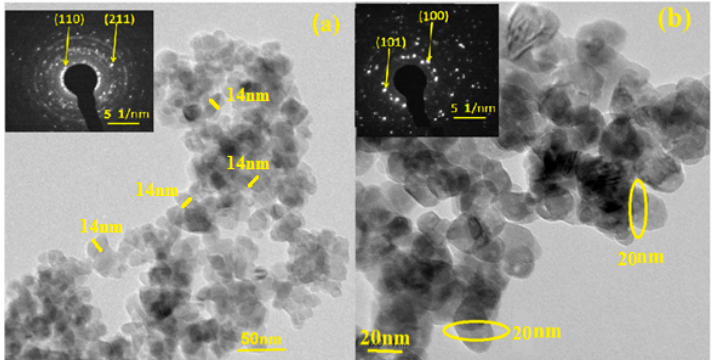
Figure 3. TEM of ( a ) Spherical morphology of FL–TiO 2 , ( b ) self-aligned in one direction Spherical particle of FL–ZnO .